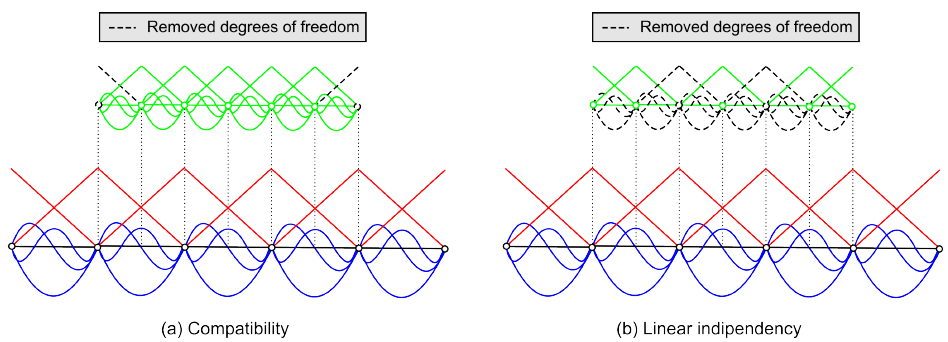
Figure 6. Conditions to satisfy when performing s − refinements: ( a ) compatibility and ( b ) linear indipen-